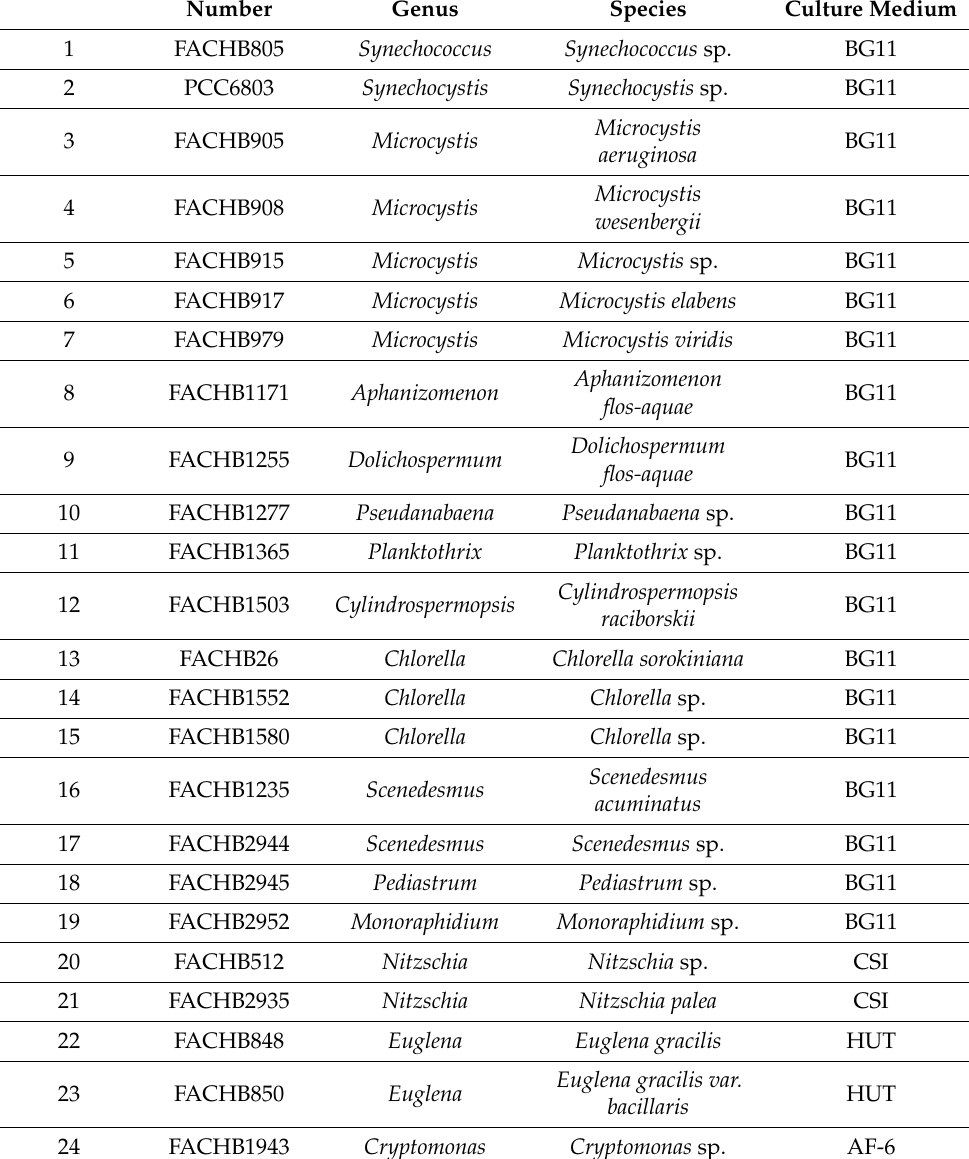
Table 2. Cyanobacteria and eukaryotic algae used in this